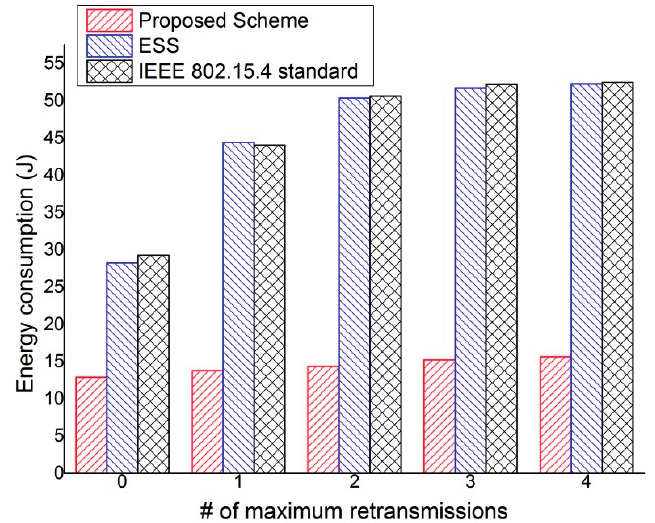
Figure 21. The total energy consumption of devices versus the number of maximum retransmissions.